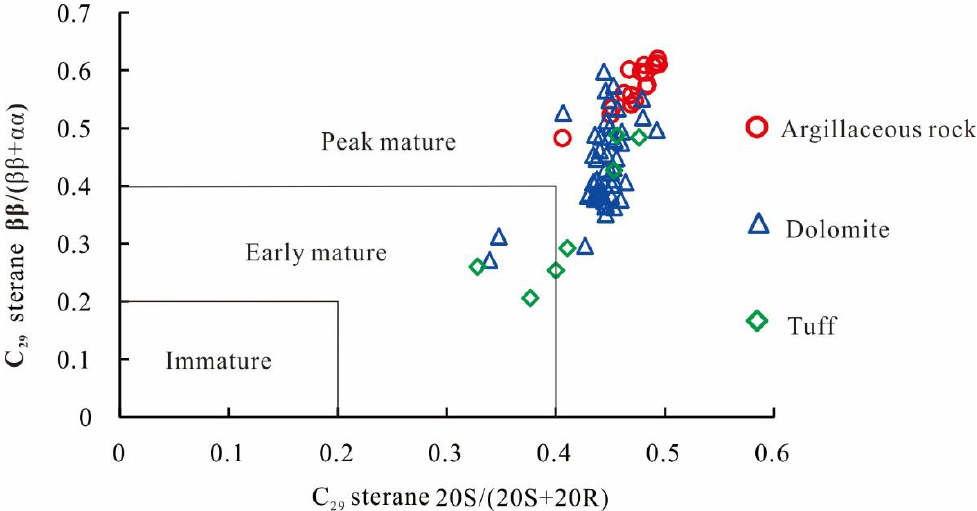
Figure 5. Discrimination diagram of the organic matter thermal evolution degree of the Fengcheng Formation in the Mahu Sag.